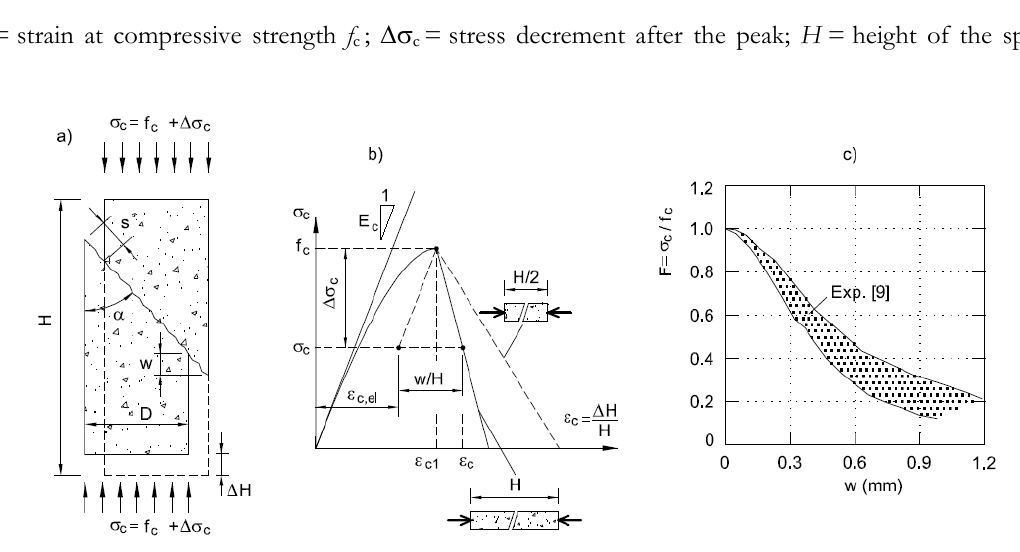
Figure 3: The post-peak response of quasi-brittle materials in